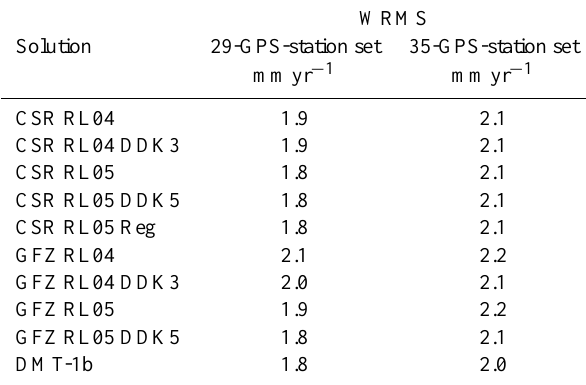
Table 3. Comparison of estimated GIA rates with GPS vertical rates, using the uncertainties for both the GPS and GIA uplift rates in the WRMS calculations. WRMS Solution 29-GPS-station